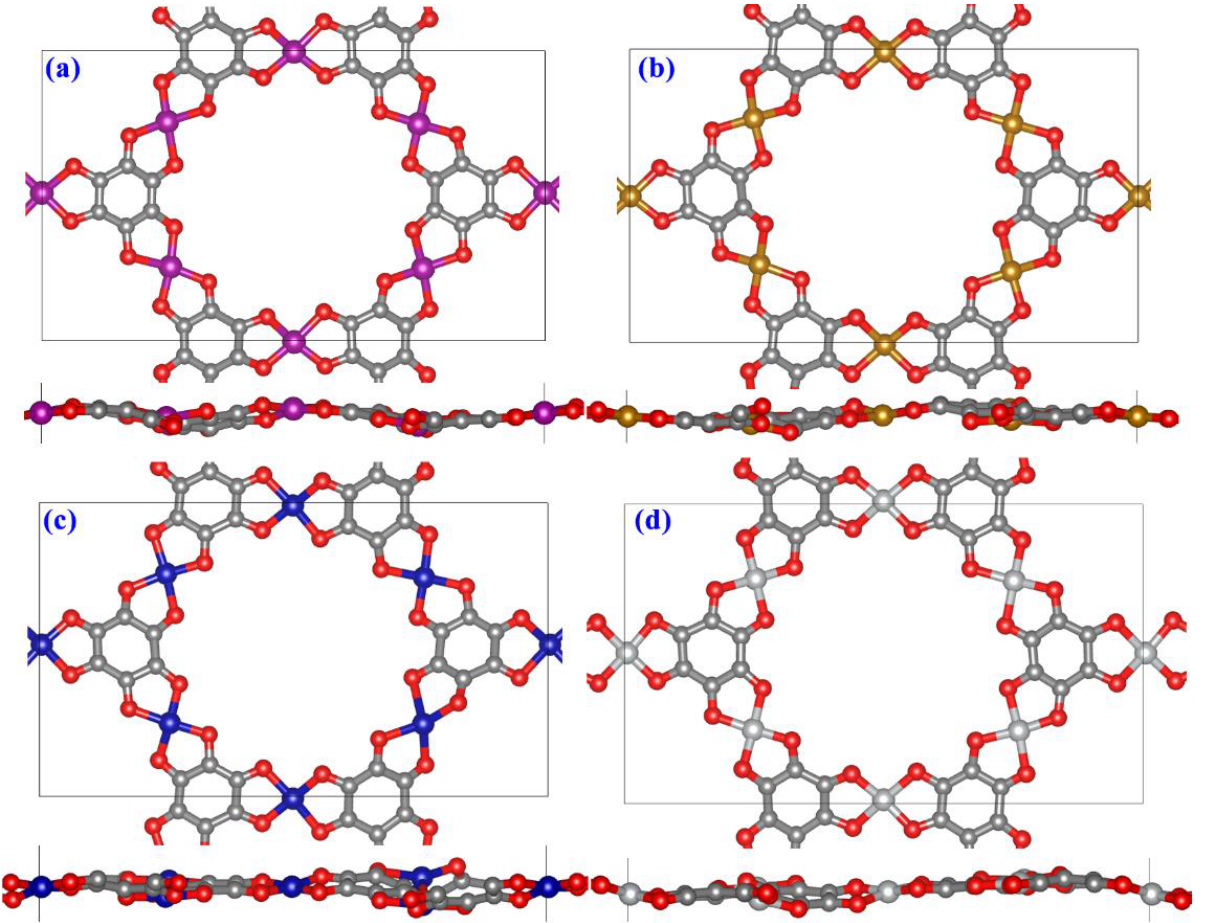
Figure 3. The final structures of ( a ) Mn-O-MOF, ( b ) Fe-O-MOF, ( c ) Co-O-MOF, and ( d ) Ni-O-MOF single-layer structures after AIMD simulations.